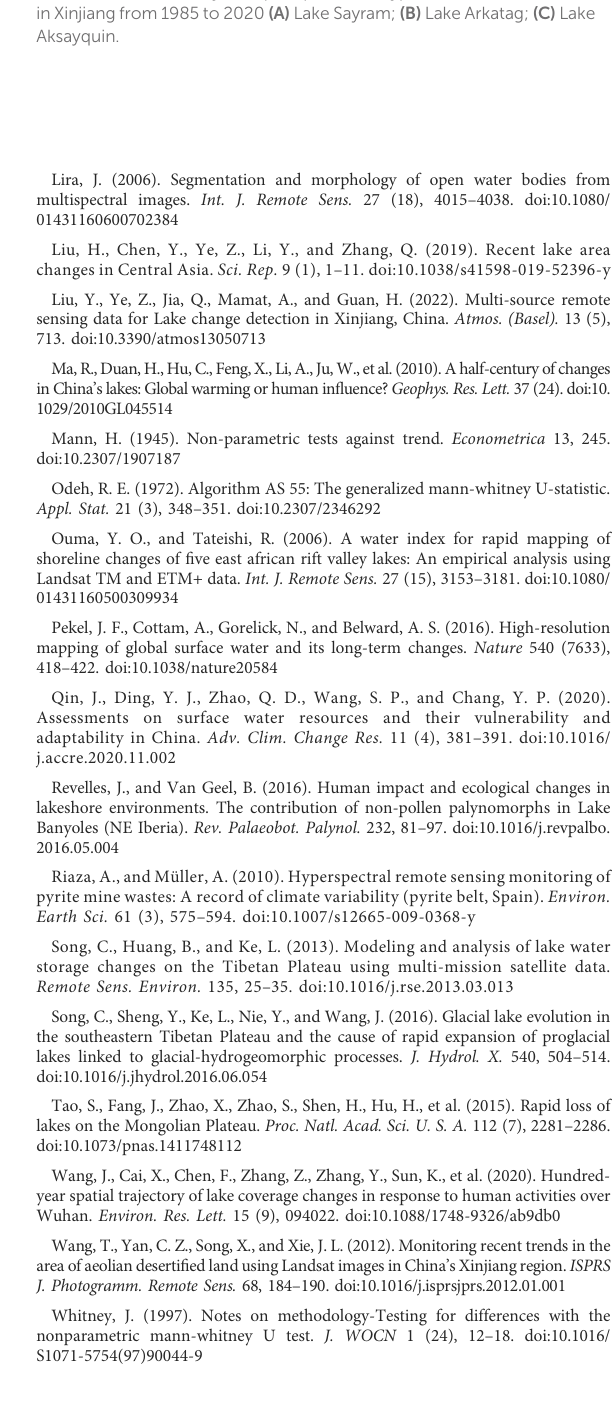
SUPPLEMENTARY FIGURE S4 Results of wavelet analysis of precipitation in typical plains lake basins in Xinjiang from 1985 to 2020 (A) Lake Ebinure; (B) Lake Bosten; (C) Lake Ulungur; (D) Lake Taitema. SUPPLEMENTARY FIGURE S5 Results of wavelet analysis of temperature in typical mountain lake basins